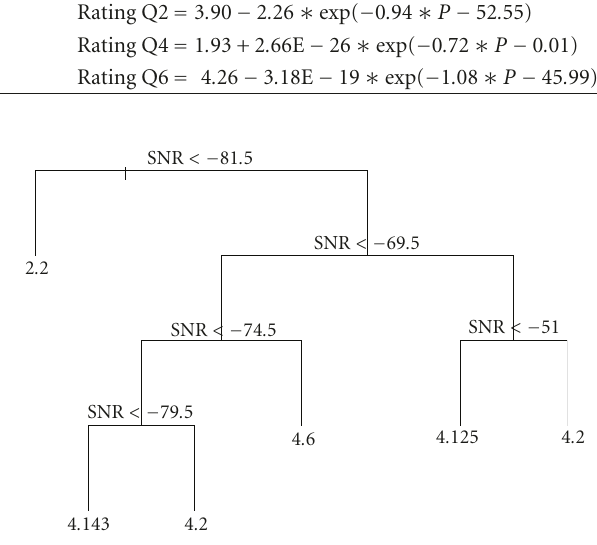
Figure 9: Regression tree of the monitored median signal strength. (The terminal nodes represent the average ratings of